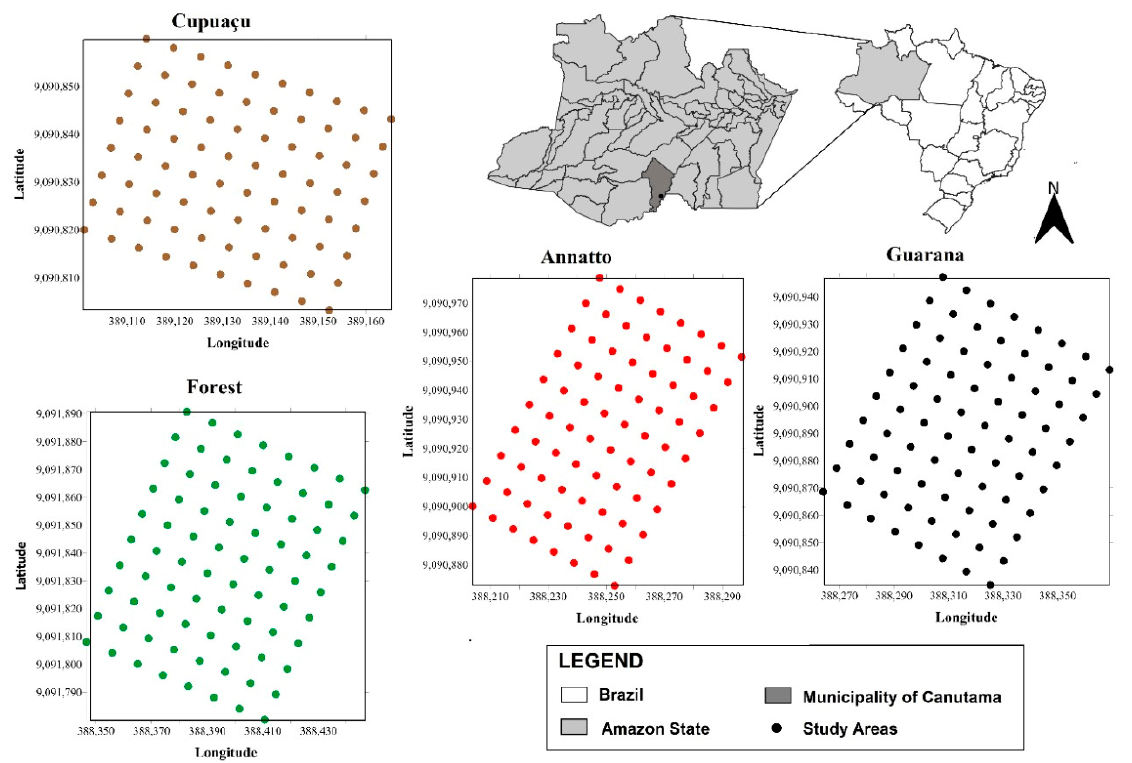
Figure 2. Location map of the study site and sampling points in the rainforest areas both native and under conversion to crop cultivation in southern Amazonas.